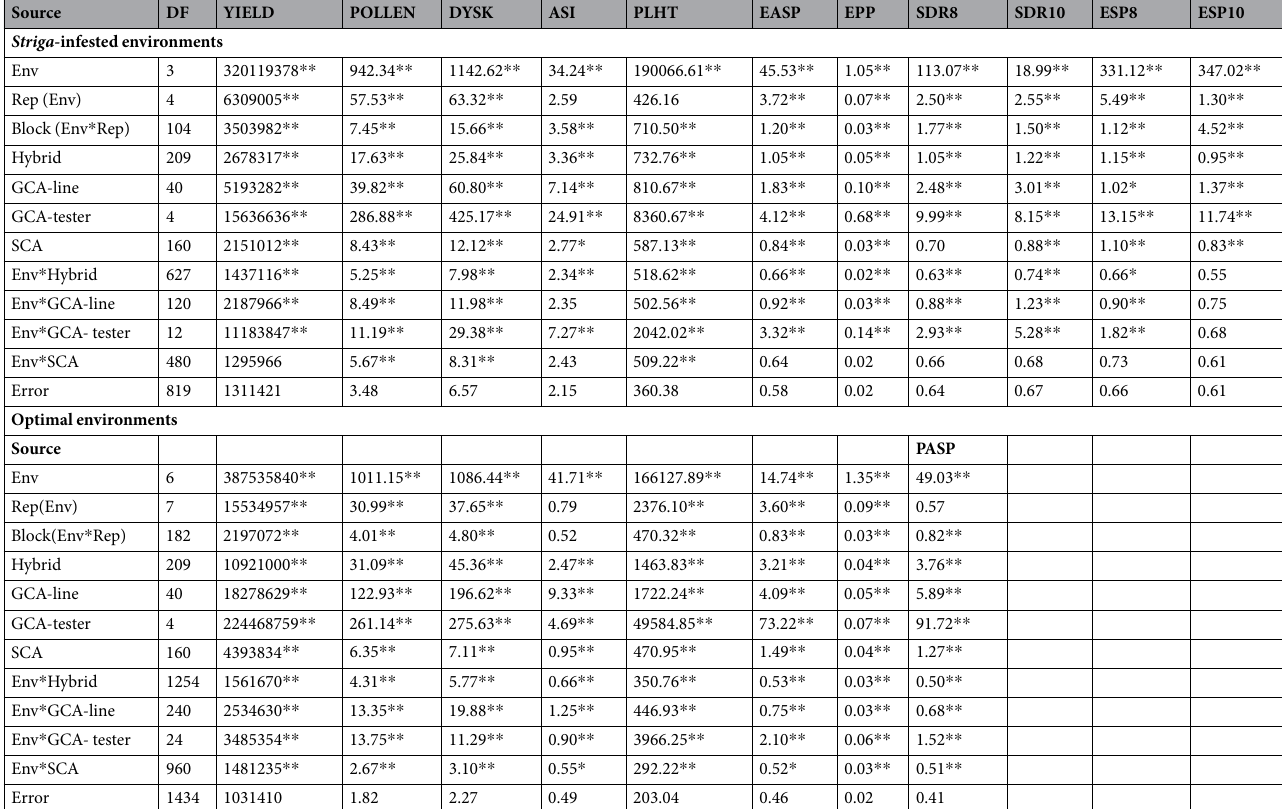
Table 2. Mean squares of different traits of early maturing yellow maize hybrids planted under four Striga - infested and seven optimal environments in 2015 and 2016. * , ** Significant at 0.05 and 0.01 probability levels, respectively; Env = environment; Rep = replication; YIELD = Grain yield (kg ha − 1 ); Pollen = days to 50% anthesis; DYSK = days to 50% silking; ASI = anthesis-silking interval; PLHT = plant height (cm); PASP = plant aspect EASP = ear aspect; EPP = ears per plant; SDR8 and SDR10 = Striga damage rating at 8 and 10 WAP; ESP8 and ESP10 = number of emerged Striga plants at 8 and 10 WAP.